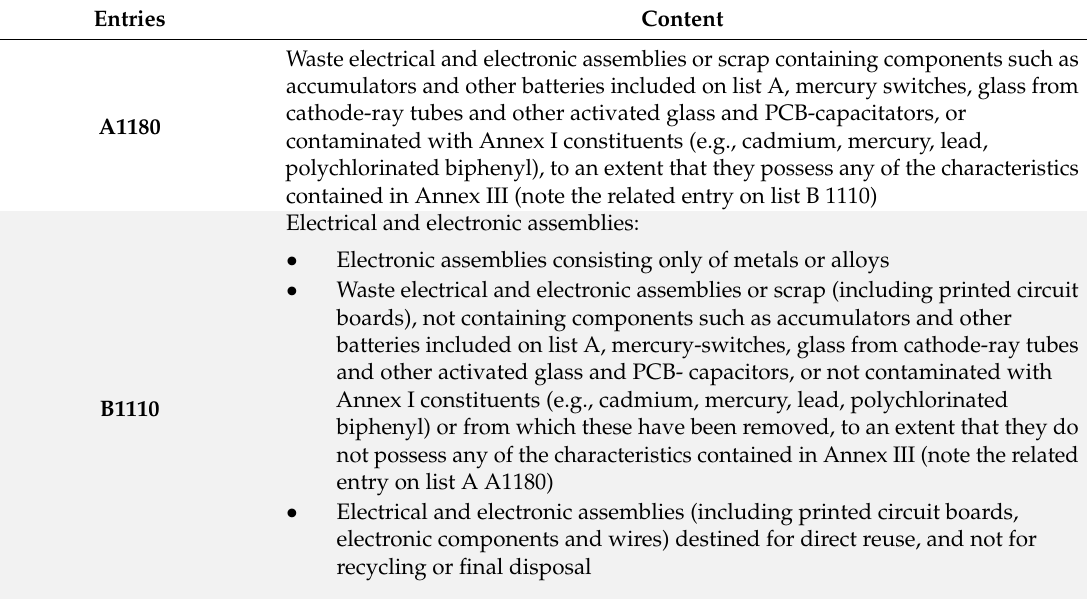
Table 3. Basel Convention on